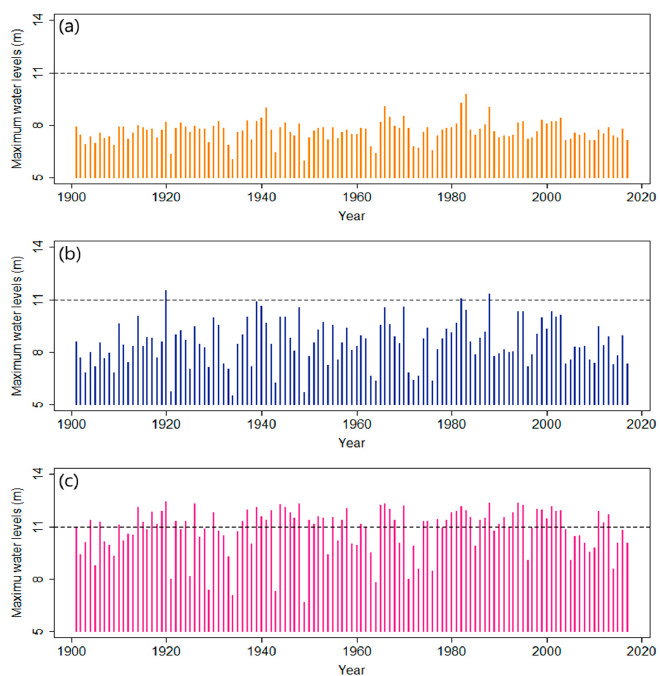
Figure 4. Time series of the maximum water levels for three different values of the level of bias β equal to 0 ( a , orange), 1 ( b , blue), and 10 ( c , magenta). The dashed line indicates the bankfull depth h BF of the channel.